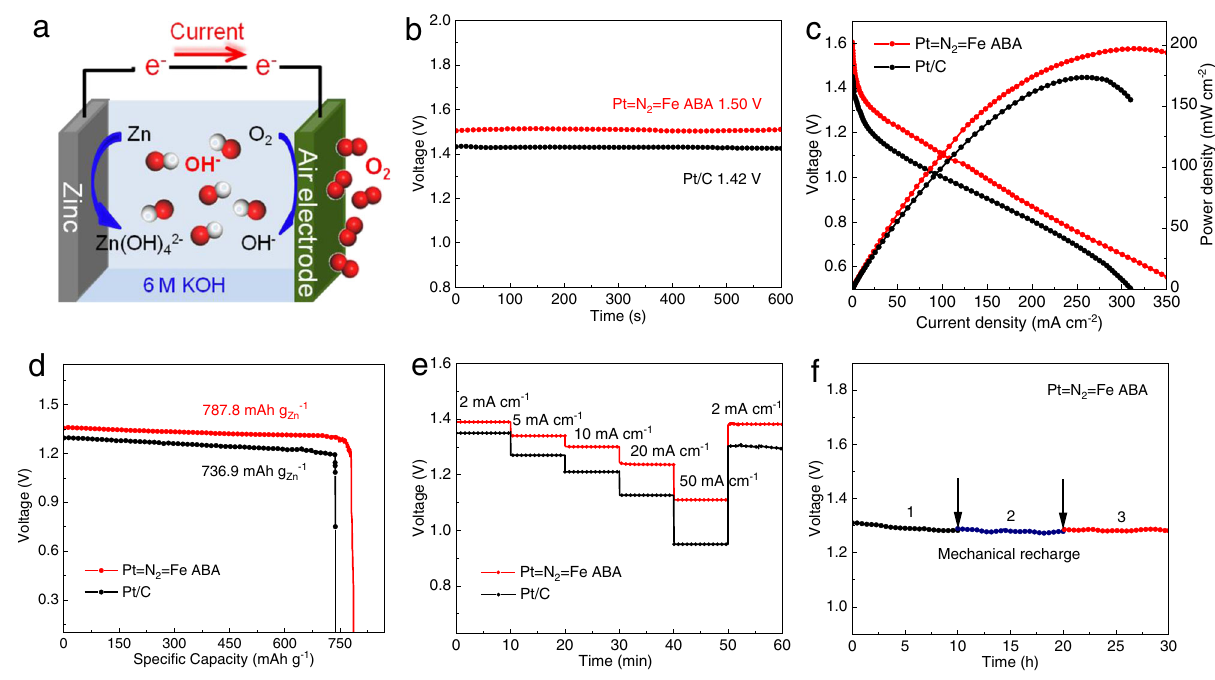
Fig.5|Zn – airbattery(ZAB)performance.a DevicediagramoftheZn ‒ airbattery. b Open-circuit voltage (OCV) of the ZAB based on Pt=N 2 =Fe ABA and the refer- ence Pt/C catalyst. c Polarization curves and power density of the assembled ZAB.